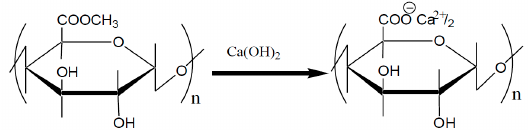
12 of 32 Figure 12. Amount of As(III) adsorbed (q As(III) ) by crosslinked pectic acid gel loaded with Fe(III) plotted against the equilibrium pH [12]. (With permission for reuse from The Society of Chemical Engineers, Japan). 5. Biosorbents Prepared from Orange and Apple Juice Residues As mentioned earlier, heavy metals and metalloids are very effectively adsorbed by crosslinked pectic acid and alginic acid gels, which have interesting adsorption characteristics. However, pure pectic acid and alginic acid are expensive, so it may be impractical to use them on a commercial scale. We therefore attempted to prepare biosorbents that could effectively and cheaply remove heavy metals and metalloids from solution using orange and apple juice residues, which are biomass waste products of the fruit juice industry, that contain large amounts of pectic acid [13,14]. However, pectic acid is present in orange and apple juice residues as pectin, which is partly methyl-esterified pectic